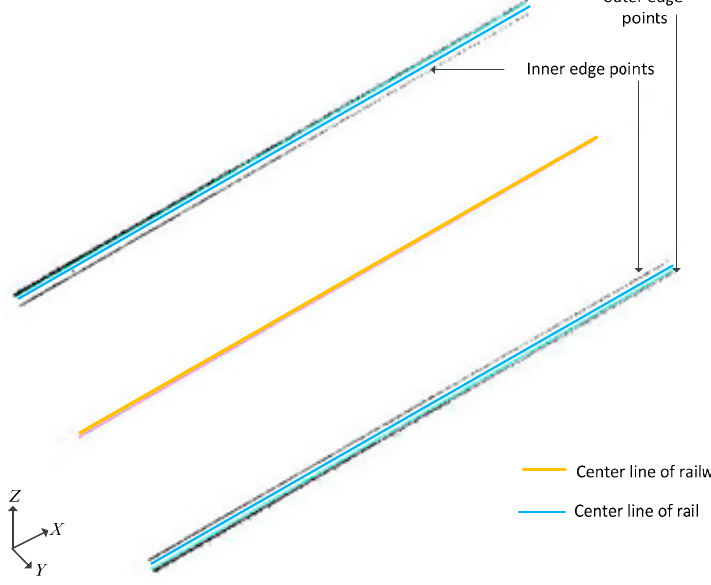
Figure 7. Rail line by 3D linear fitting using least square approach.